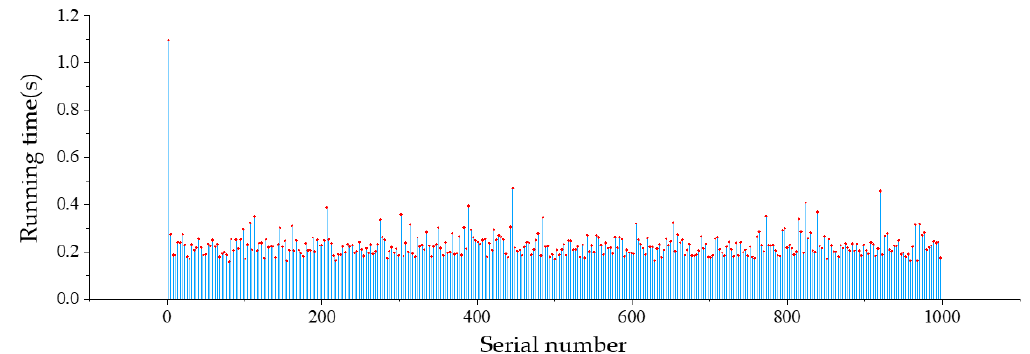
Figure 21. Running time of the wind prediction model and PSO-based algorithm on Raspberry Pi 4B+.